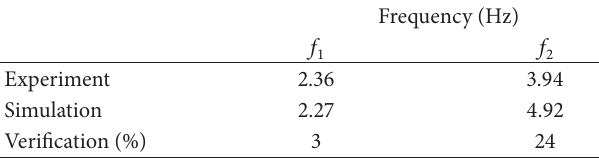
Table 6: Comparison of